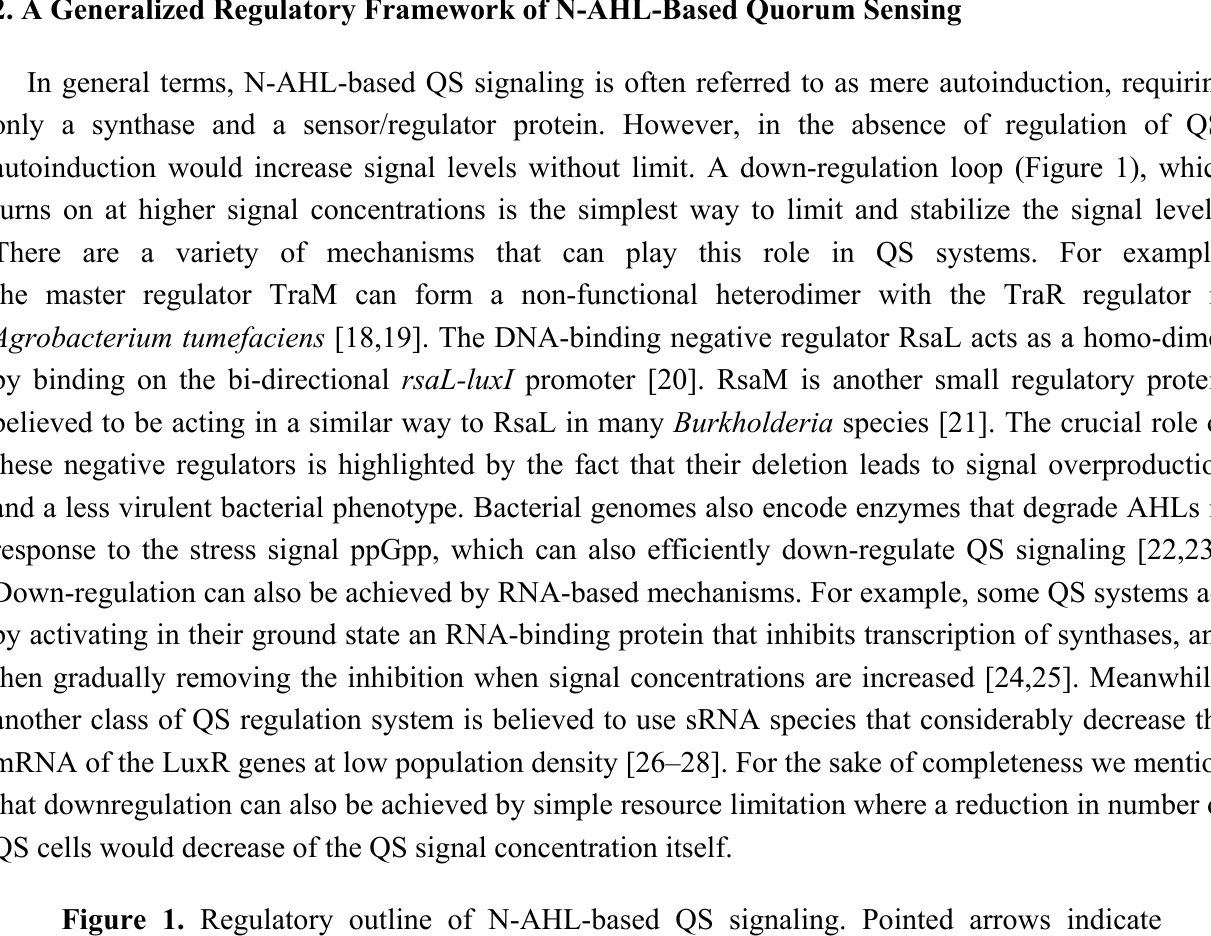
Figure 1. Regulatory outline of N-AHL-based QS signaling. Pointed arrows indicate activation, and the hammerhead arrow indicates